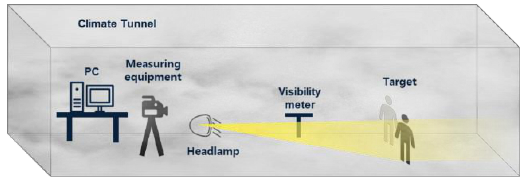
Figure 3. Test environment concept.